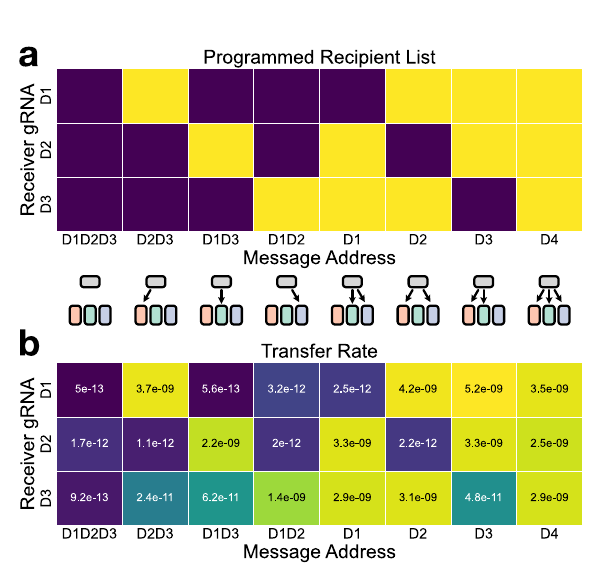
Fig. 3| Cas9-mediated cleavageofincoming plasmidscanbiastheirtransferto targeted recipients. a Schematic of the experimental setup. Senders ( S ) and Receivers ( R ) carrying one of two plasmid variants are grown together in a cocul- ture,andselectiveplatingisusedtoisolatethem,aswellasthetransconjugants(T), from the mixed culture. Note that transconjugants will appear on the receiver- selecting plates, so R is the total density of receivers in the population (Methods).